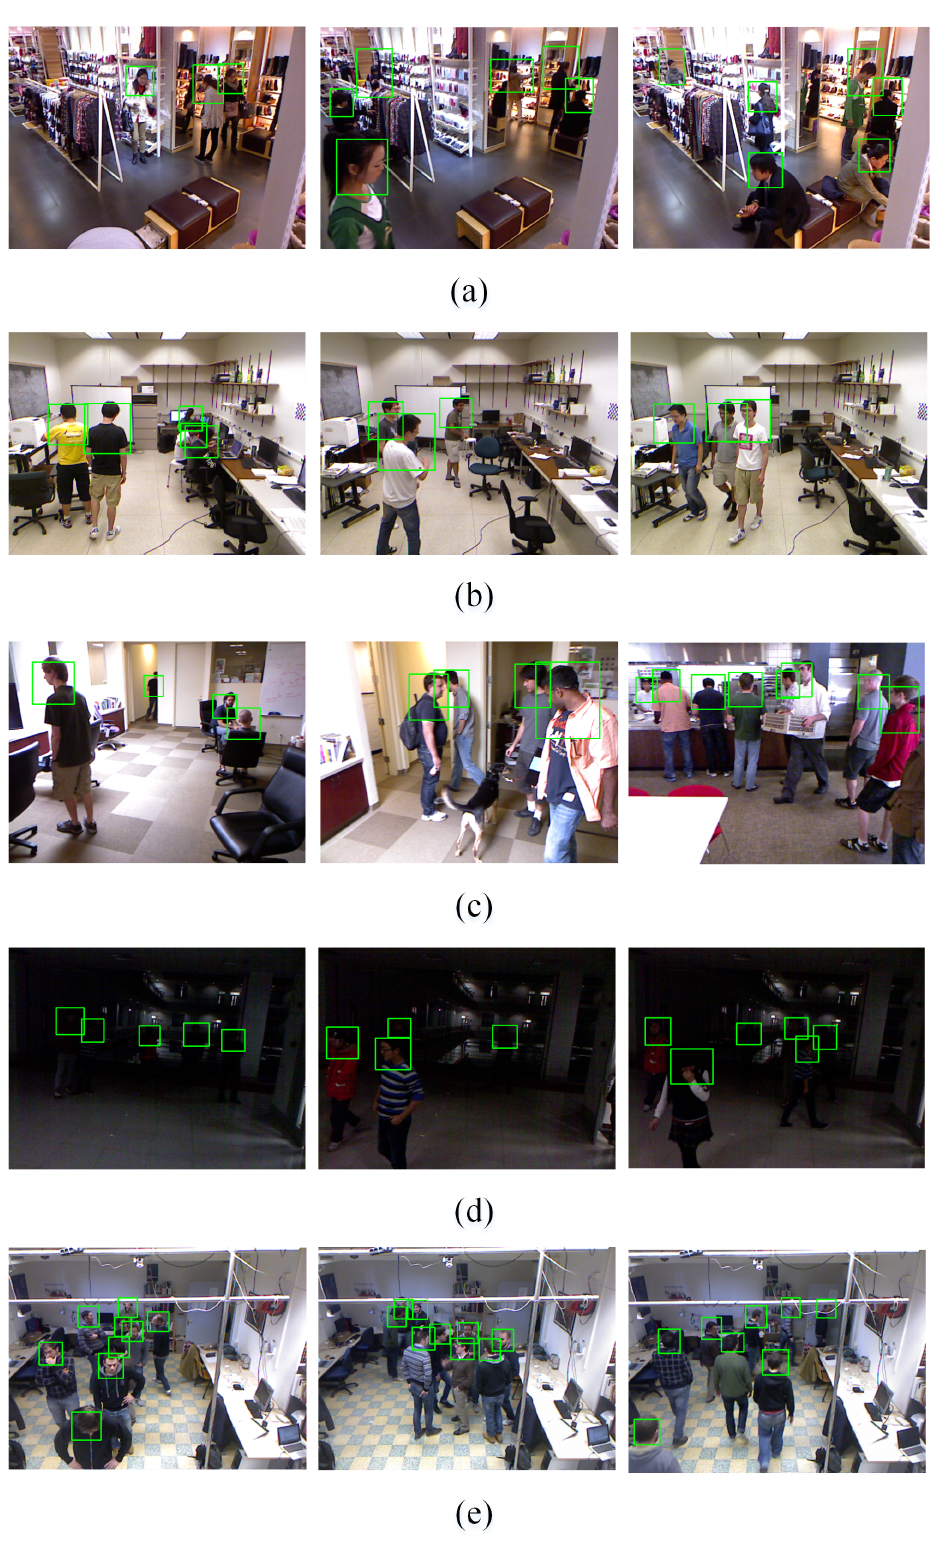
Figure 7. Results of AAFTS-net on each subset: ( a ) CLOTH, ( b ) OFFICE, ( c ) MOBILE, ( d ) DARK, and ( e )